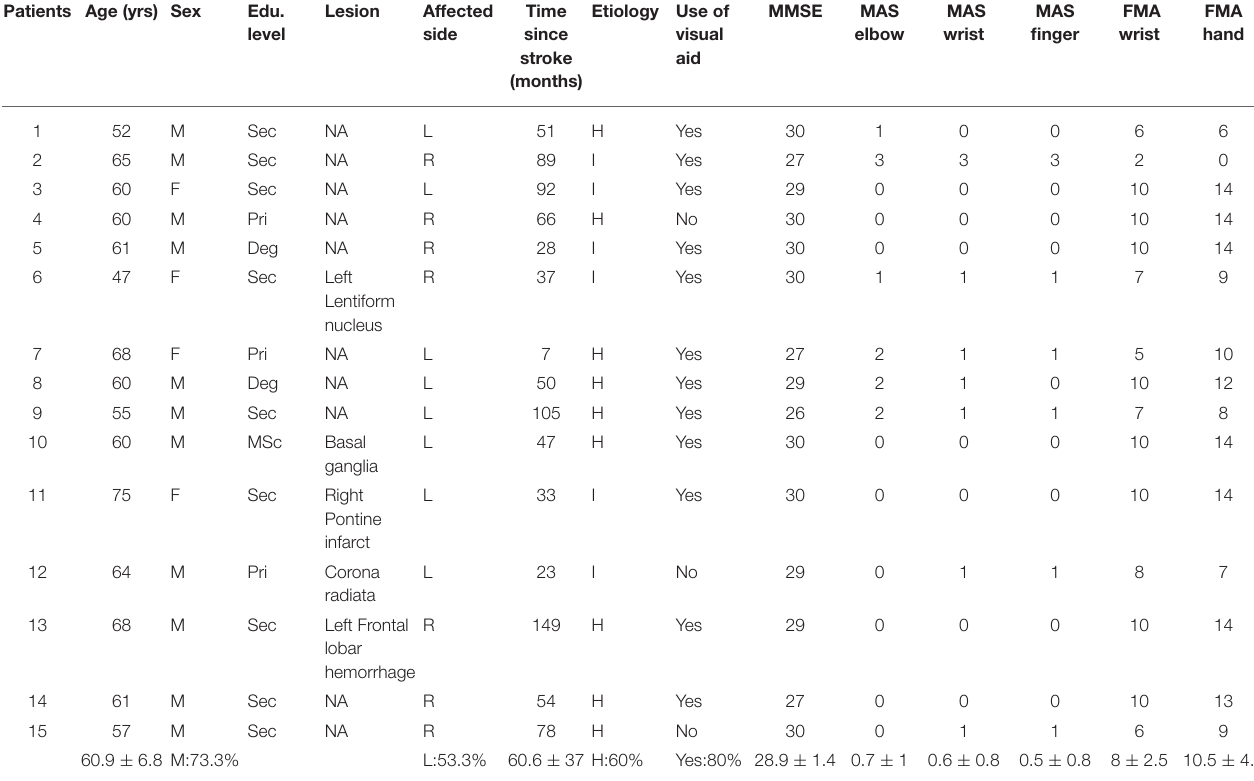
TABLE 2 | Socio-demographic and clinical characteristics of the post-stroke patients ( n = 15). Patients Age (yrs)